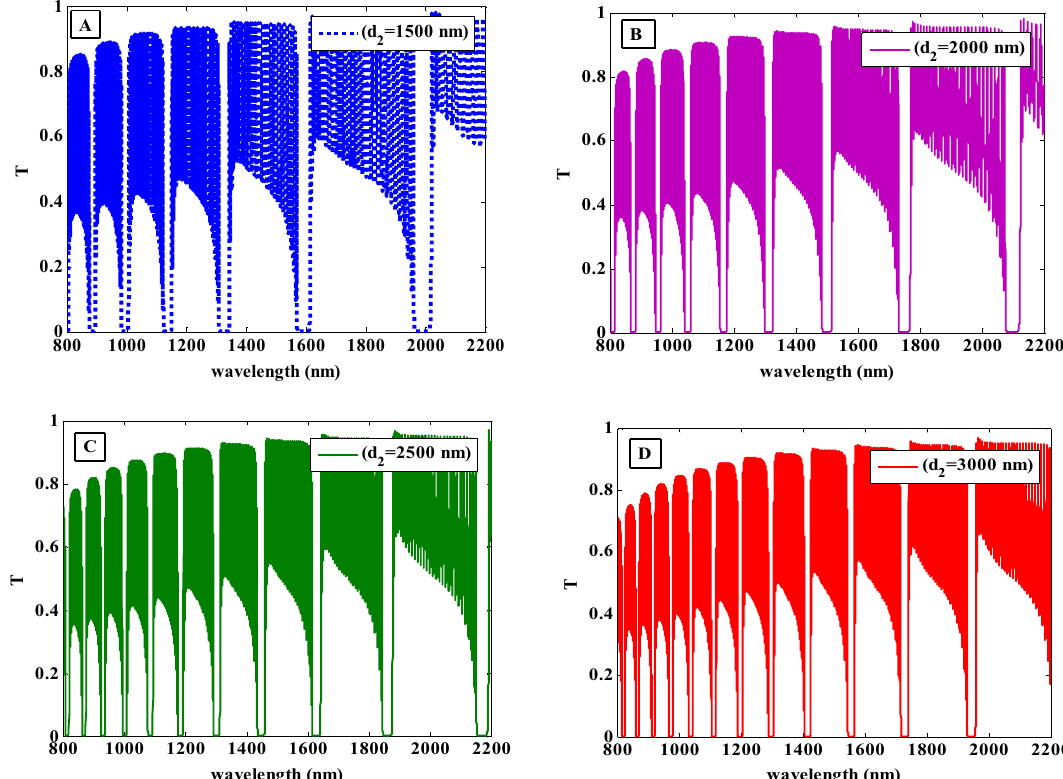
Figure 7. The transmittance spectra of the suggested one-dimensional photonic crystal design at different thickness of HMM